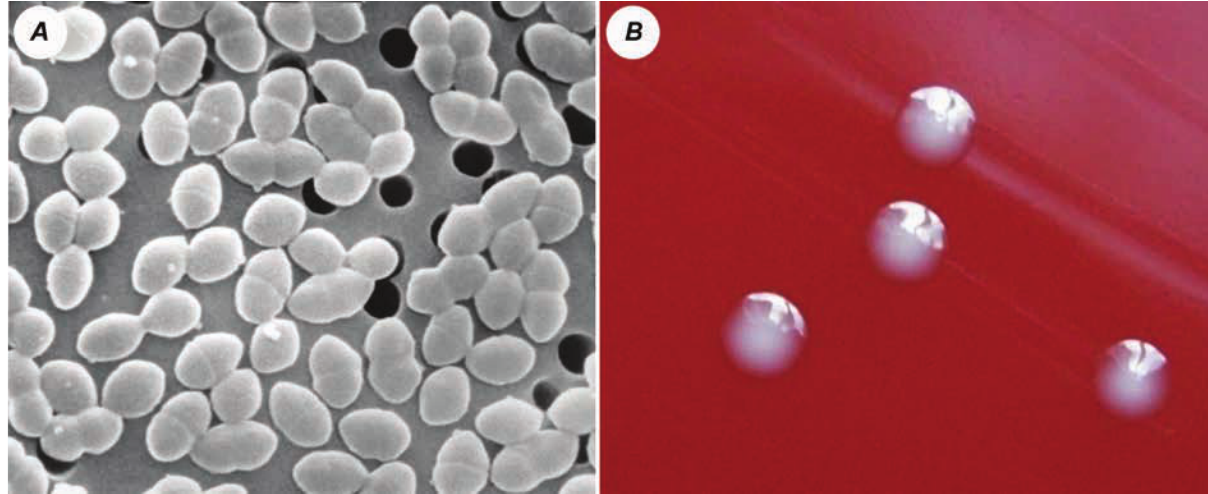
Figure 1: Enterococci cells, scanning electron microscope ( A ) [9] and the colonies of Enterococcus faecalis, blood agar, 24 hours cultivation, 37°C ( B )